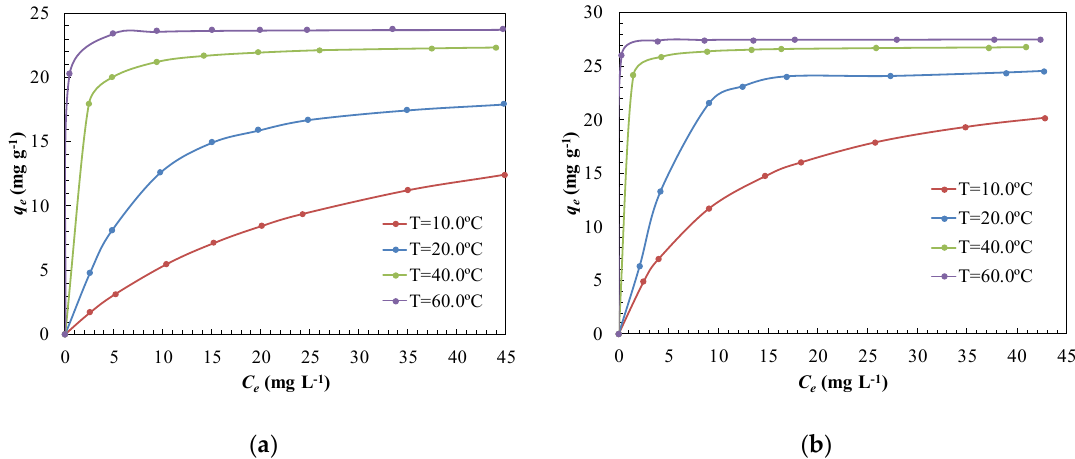
Figure 4. Adsorption isotherms of ( a ) aniline at pH = 12.0 and ( b ) benzothiazole at pH = 8.0 on TiO 2 P25 catalyst at different temperatures.